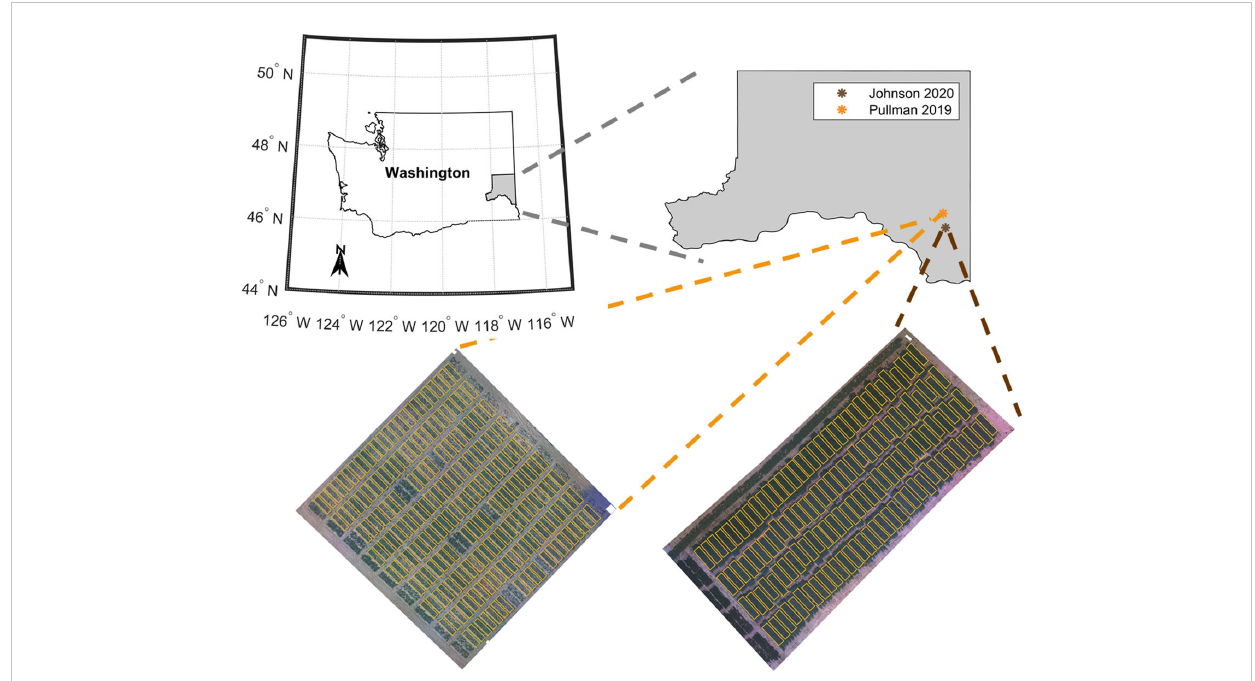
FIGURE 1 Location of the pea breeding fi eld trials located in the Paci fi c Northwest region of USA in the state of Washington, USA: advanced yield trial grown in Pullman, Washington (including check varieties used as reference) evaluated in 2019 season (Site 1) and variety test trial grown in Johnson, Washington (including check varieties used as reference) evaluated in 2020 season (Site